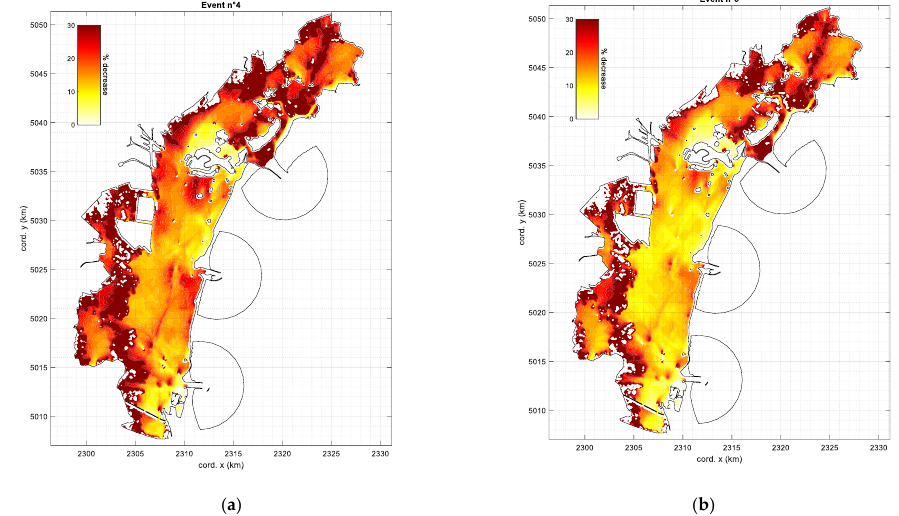
Figure 9. Percentage decrease between the modelled H s in the closed and open barrier scenarios for ( a ) event no. 4 (28 December 2020) and ( b ) no. 5 (22 January 2021). In the red, the decreases are larger than 30%.